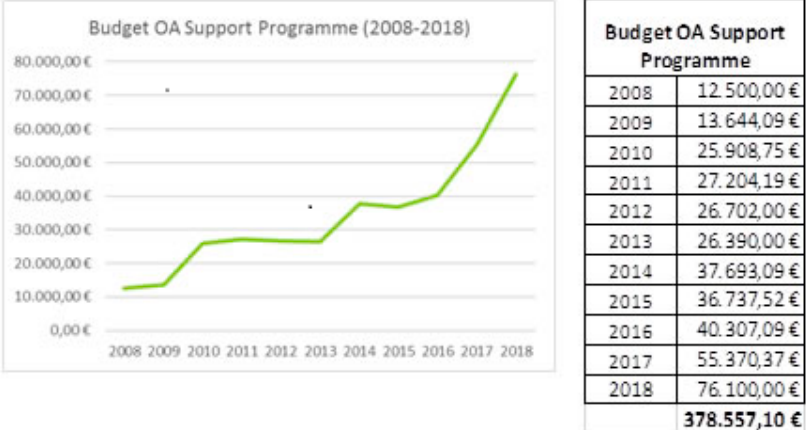
Figure 3. CSIC Budget for Open Access Publishing Support Programme.